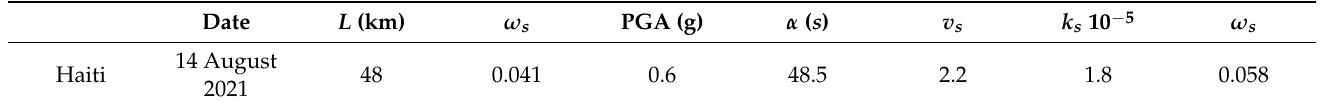
Table 2. Parameters used for the evaluation of the dispersion relation for pressure fluctuations associated with the 2021 Haitian